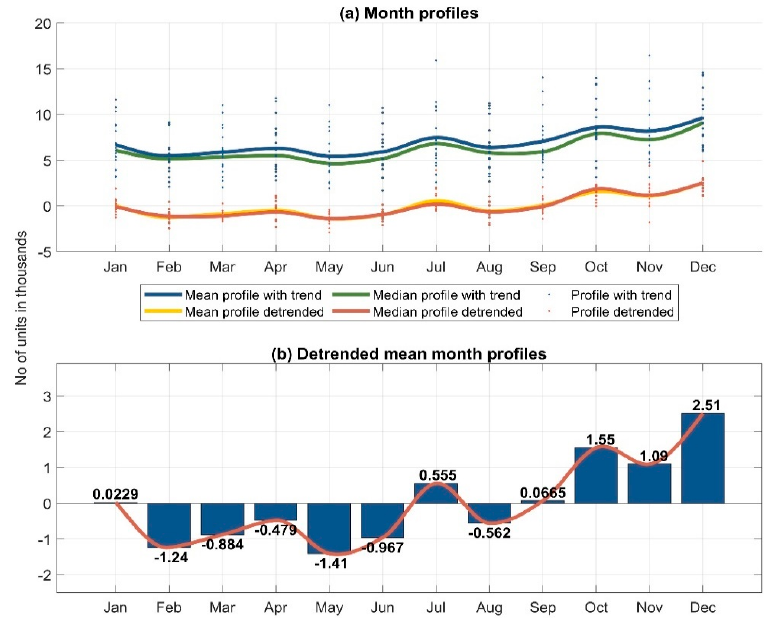
Figure 9. Averaged annual profile. Housing units completed—for sale or rent (Source: own compilation based on data from CSO).